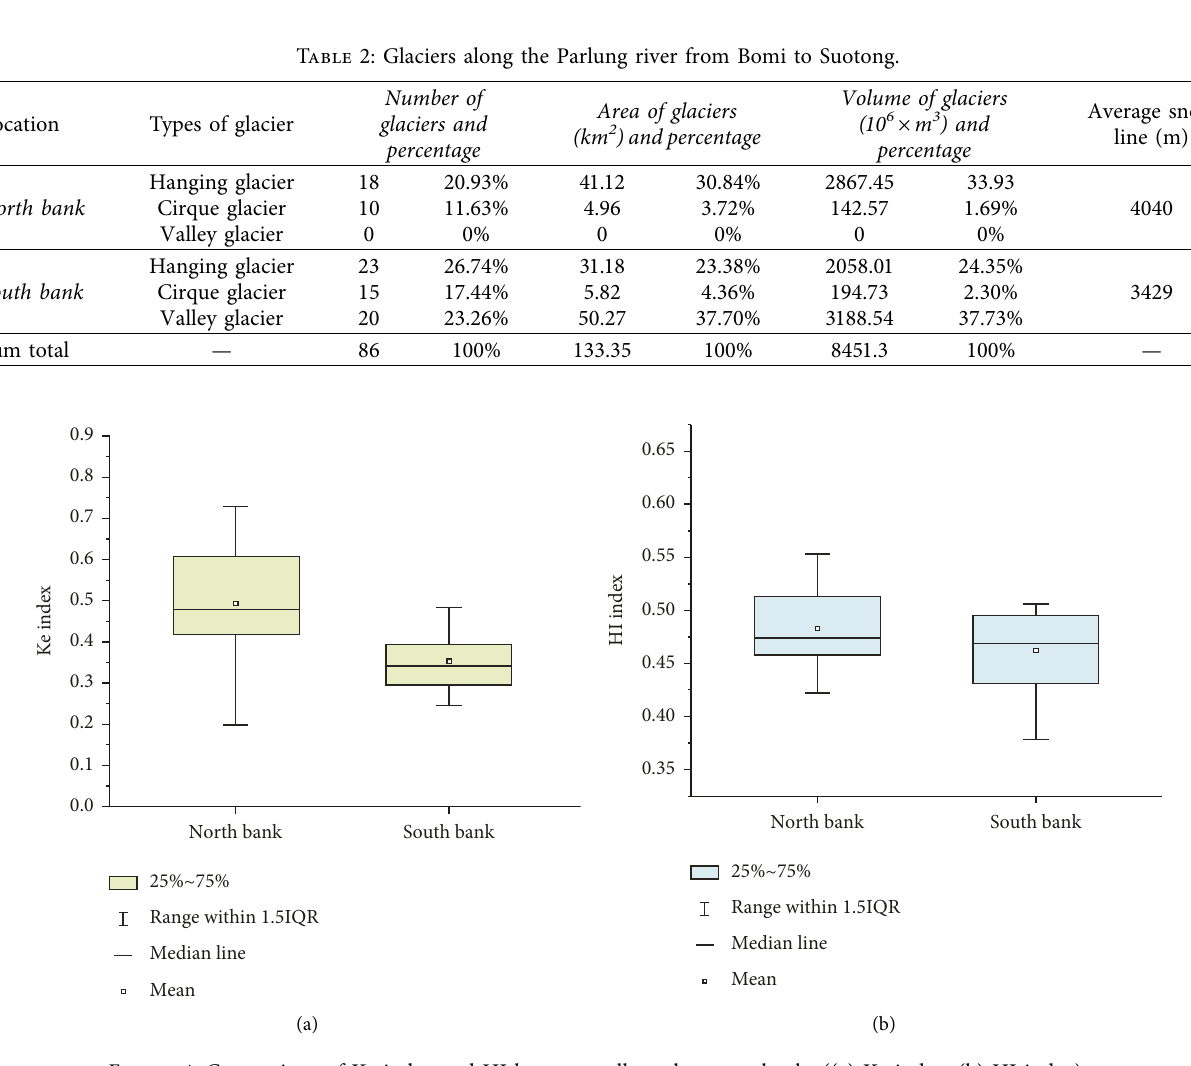
Figure 4: Comparison of Ke index and HI between valleys along two banks ((a) Ke index; (b) HI